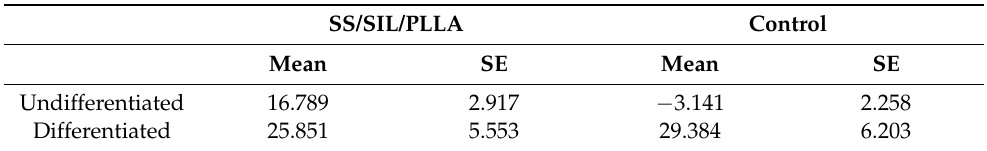
Table 4. ARS semi-quantification in mM between groups. Results of % mineral deposition enhance- ment are presented in mean ± SE, normalized to the SS/SIL as